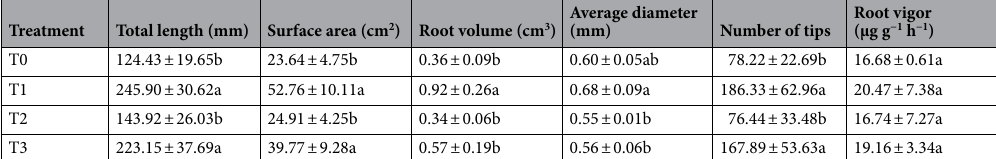
Table 6. Effects of the mixture of rice husk ash and red soil with various proportions on root architectures of cotton